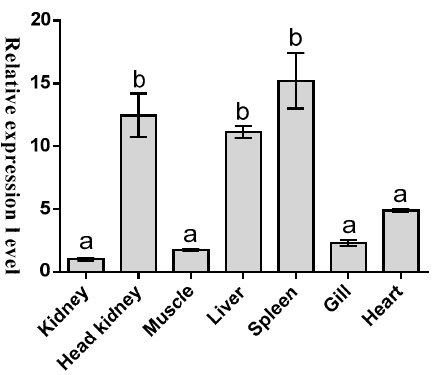
Figure 4. The expression of Malitaf mRNA in different tissues from healthy M. amblycephala . Significant pairwise expression-level differences between tissues are indicated by different letters above the bars.